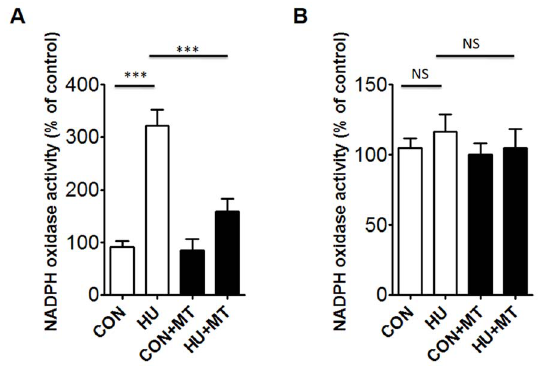
Figure 5. NADPH oxidase activity in rat cerebral (A) and mesenteric (B) vascular smooth muscle cells. CON, control; HU, hindlimb unweighting; CON + MT, mitoTEMPO-treated control; HU + MT, mitoTEMPO-treated HU. Values are mean 6 SEM. *** P , 0.001 for HU vs . control or HU +